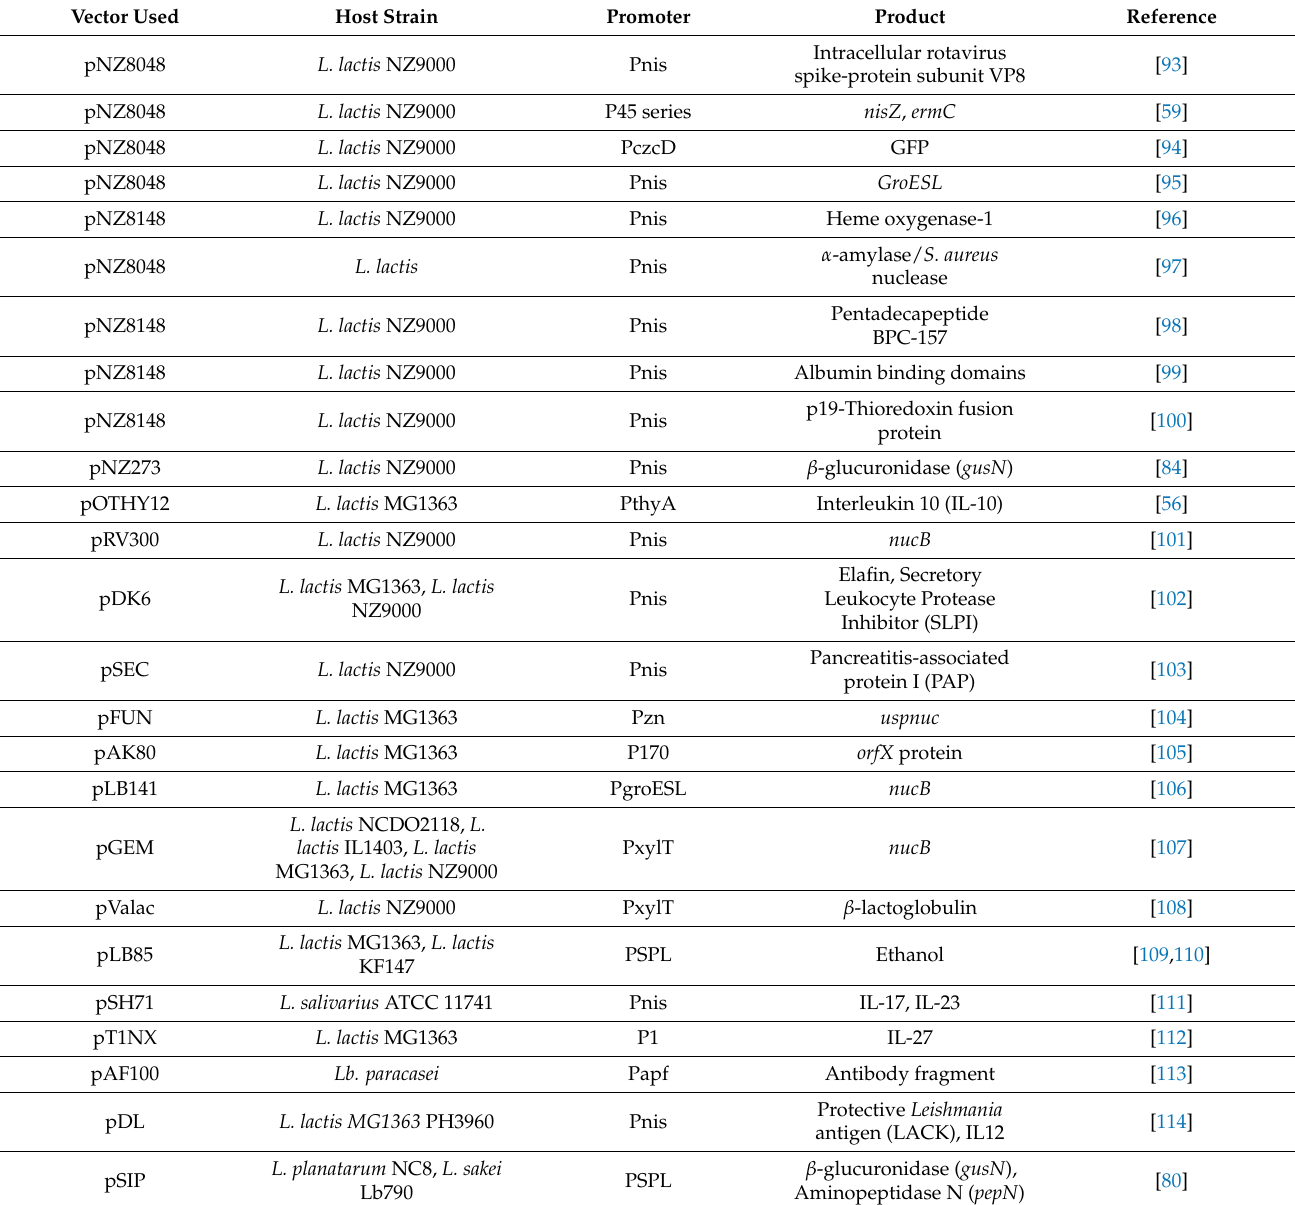
Table 3. Heterologous proteins produced in LAB using the plasmid-based gene expression